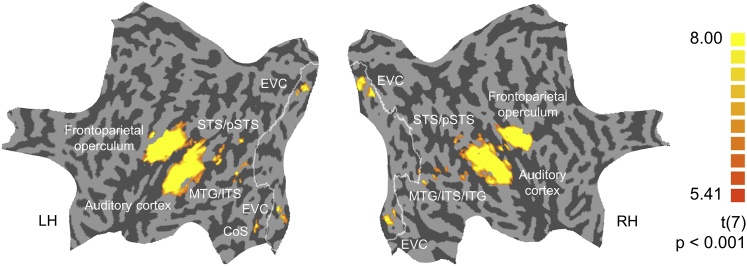
Results of the Whole-Brain Searchlight Analysis in the Blind GroupBrain regions in which a searchlight (cube with 7 voxels length—343 voxels in total) achieved above-chance classification accuracy of sounds in the blind group. Threshold: p < 0.001 voxelwise, corrected for multiple comparisons using cluster extent. The searchlight analysis was performed in the volume space, and results are displayed on a standard flattened cortical surface reconstruction for visualization purposes. White outlines represent combined Brodmann areas 17 and 18, as defined by a BrainVoyager brain atlas. CoS, collateral sulcus; EVC, early visual cortex; ITG, inferior temporal gyrus; ITS, inferior temporal sulcus; MTG, middle temporal gyrus; pSTS, posterior superior temporal sulcus; STS, superior temporal sulcus. See also Figure S2.